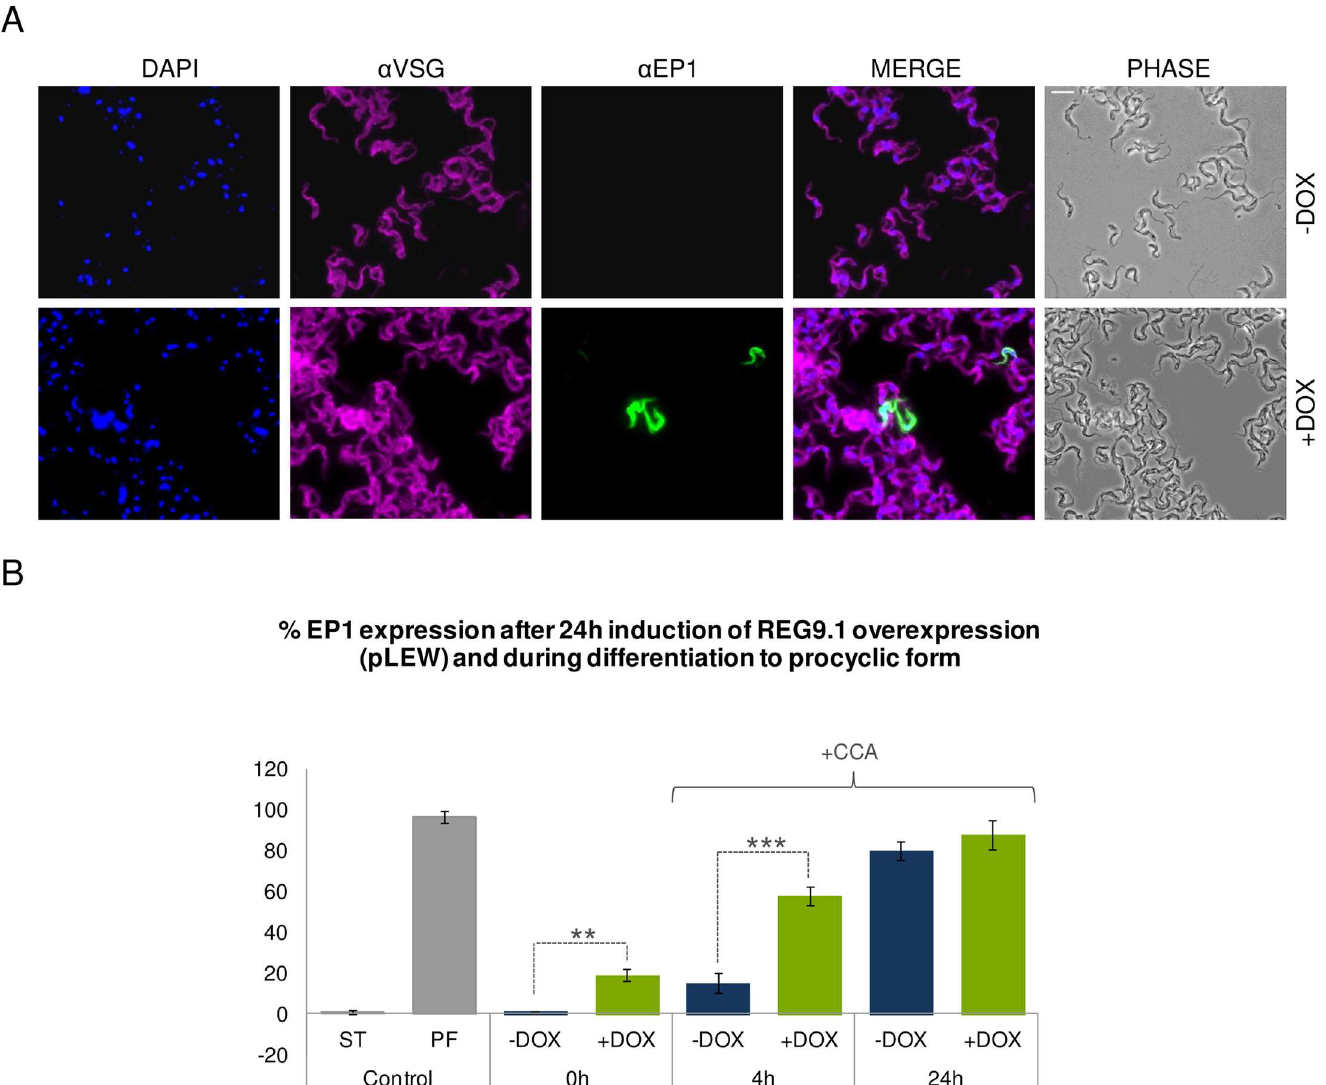
Fig 8. Ectopic expression of REG9.1 in pleomorphic trypanosomes potentiates differentiation. A. Immunofluorescence showingEP procyclin expressionon pleomorphic parasites inducedto express REG9 . 1 ectopicallyusing pLEW. α VSG AnTat1.1 is used as a marker of the bloodstreamforms surface. B. Flow cytometry showingEP procyclinexpressionon pleomorphicslenderparasitesinducedto express REG9 . 1 ectopicallyusing pLEW. 24h after inductionparasiteswere resuspended in procyclic form culture medium (SDM79) and inducedto form procyclic forms in the presenceof cis aconitate (+CCA). Inducedcells differentiated faster than the uninduced( ** , P < 0.01; *** , P < 0.001).